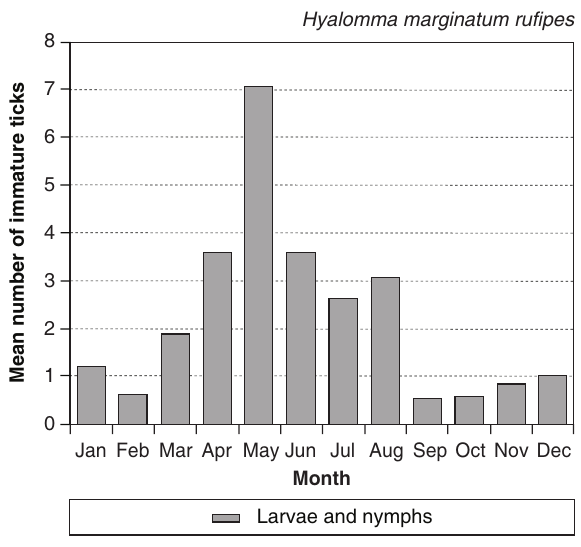
FIG. 1 Seasonal occurrence of the immature stages of Hyalomma marginatum rufipes on birds in Free State Province, South